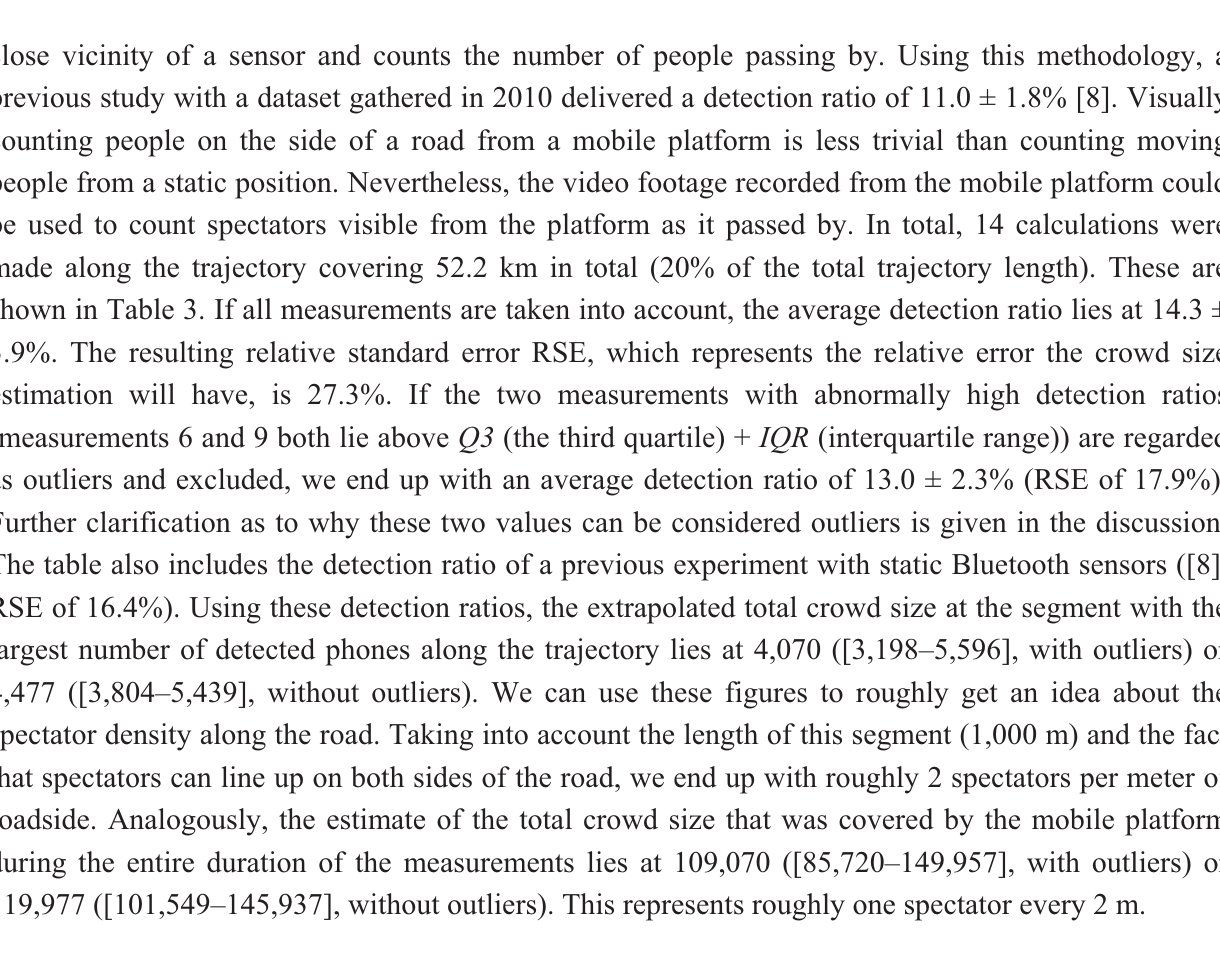
Table 3. Detection ratios along the trajectory, calculated by comparing the numbers of detected Bluetooth phones with visual spectator counts from video recordings. The two greyed out rows represent abnormally high detection ratios and can be regarded as outliers. The bottom part of the table shows the average detection ratios, standard deviations and relative standard errors with and without pruning of the